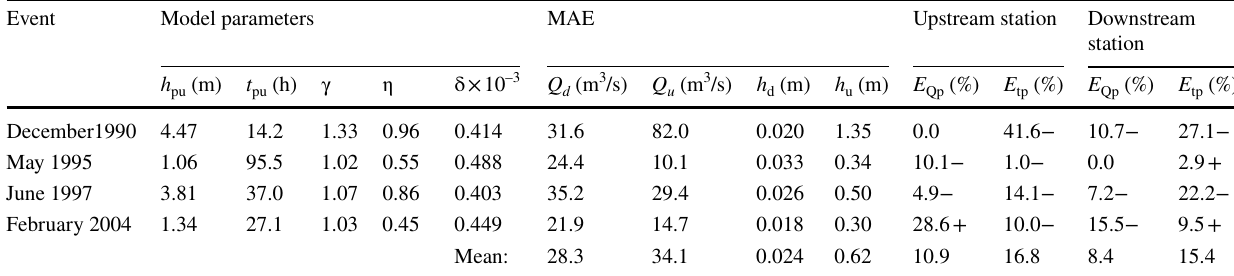
Table 2 Optimal values of the model parameters and the perfor- mance measures for the events observed in S. Lucia-P. Felcino river reach ( h pu : upstream peak stage, t pu : upstream stage peak time, γ, η,